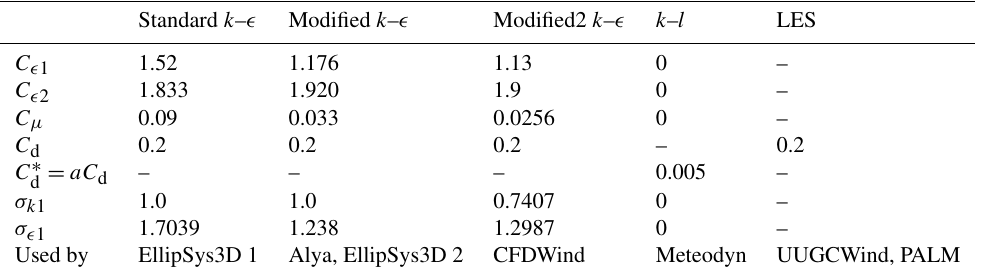
Table 2. Summary of the model constants